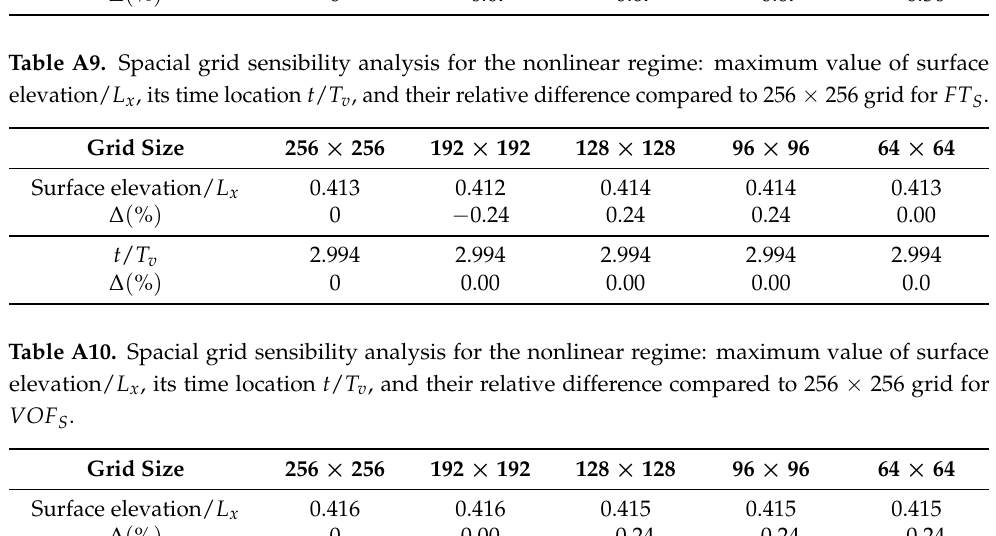
Table A9. Spacial grid sensibility analysis for the nonlinear regime: maximum value of surface